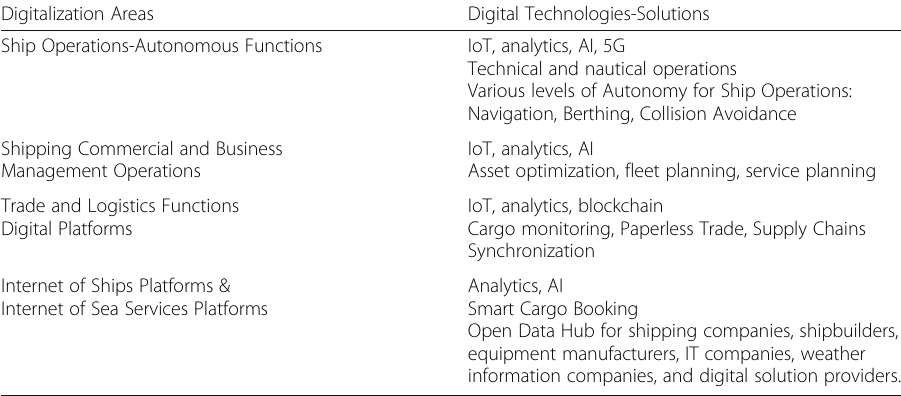
Table 1 Shipping Digital Solutions Digitalization